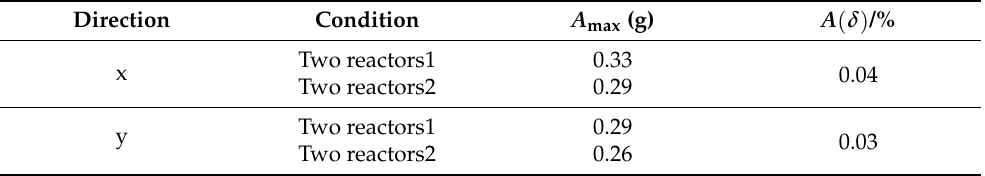
Table 10. Comparison of peak acceleration of the two reactors located at one